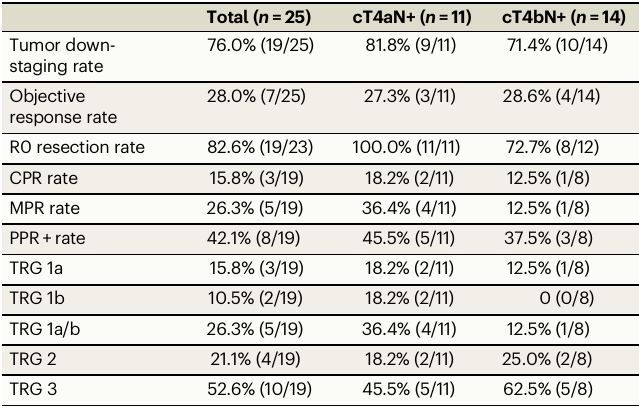
Table 2 | Ef fi cacies of the neoadjuvant/conversion